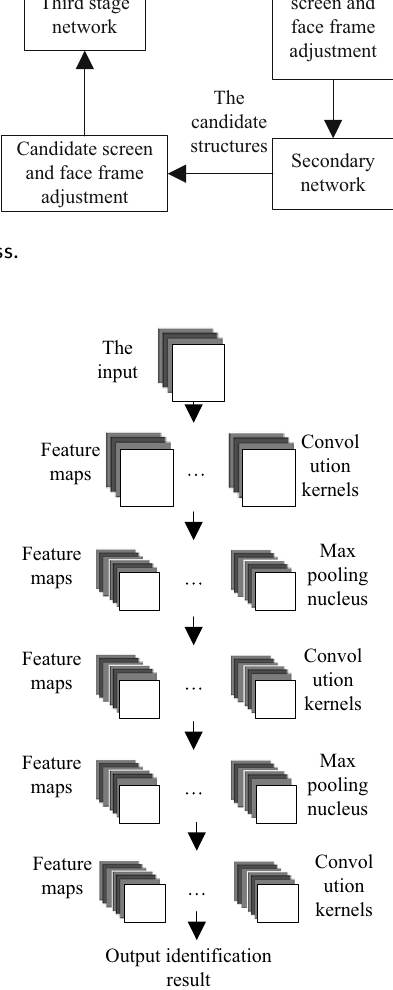
Figure 2: The second level network